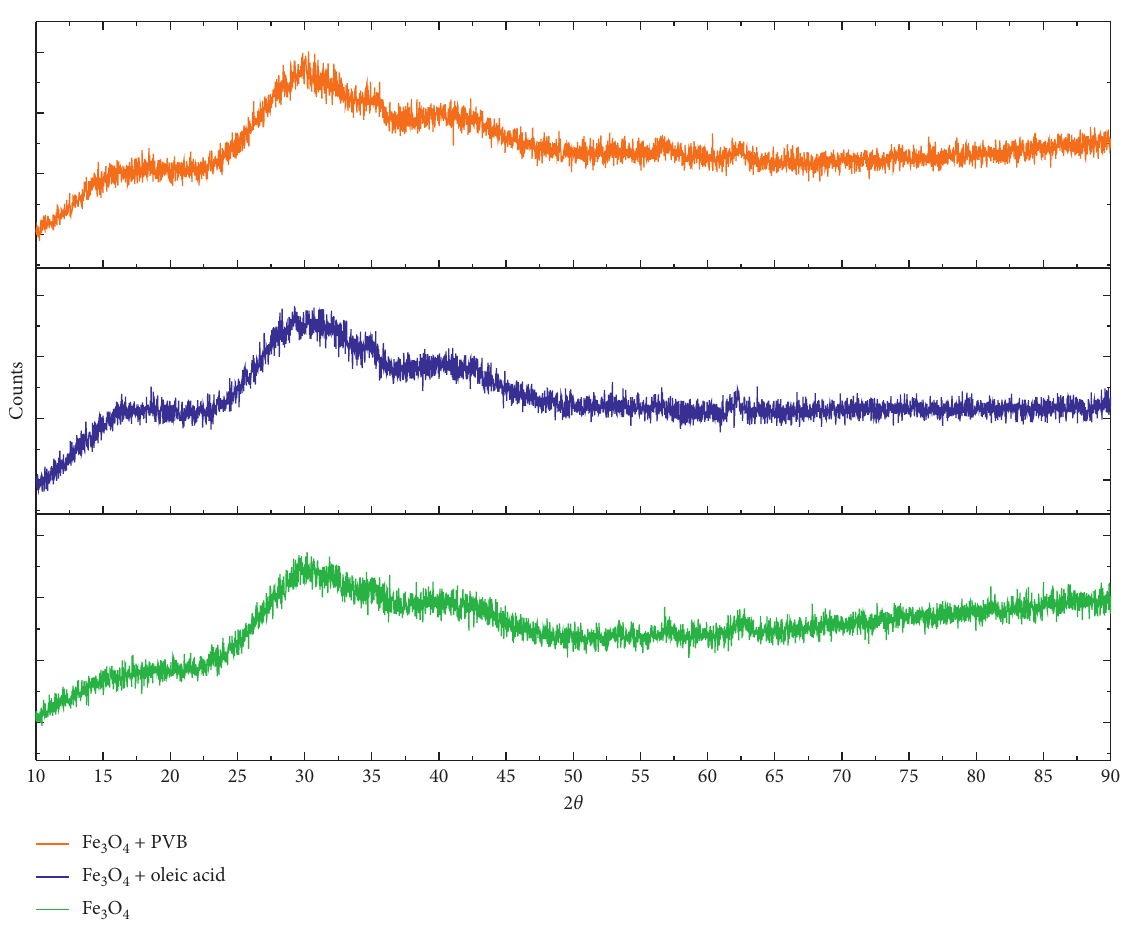
Figure 4: X-ray diffraction pattern of all the forms of Fe